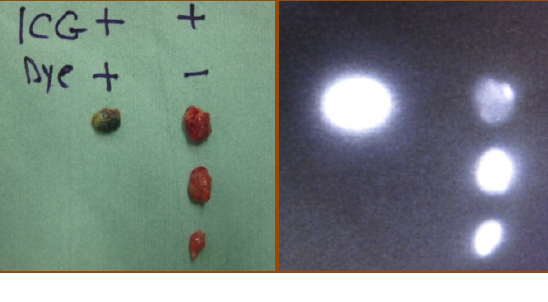
Figure 2. All removed lymph nodes were classified in terms of fluorescent signal and/or blue